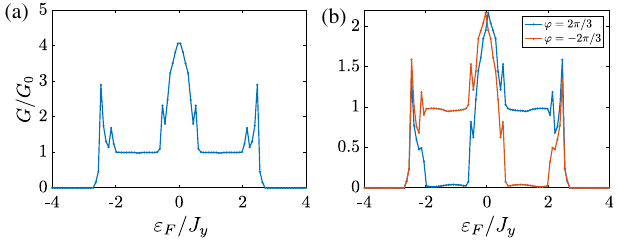
FIG. 8. Conductance of the shaken-channel model described by Eq. (8) when neglecting the anisotropy in the hopping, as obtained from the Floquet RGF method and Floquet sum rule 11 , N 12 , φ ¼ 2 π = 3 , in Eq. (11). Parameters are λ y ¼ cut ¼ J J κ ¼ 0 . 03 ω =l n 11 . (a) The sum in Eq. (11) y ¼ 1 , H , and F ¼ is taken over all the Floquet modes, from n ¼ − 11 up to n ¼ n 11 ; (b) the sum is performed up to the n ¼ 5 F ¼